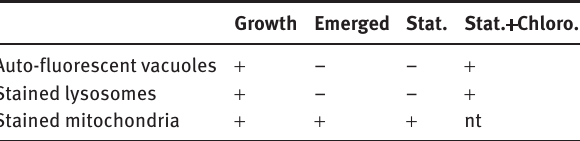
Table 1: Summary of the fluorescent properties of the auto- fluorescent vacuoles, lysosomes stained with NBD-PZ, and mitochondria stained with MitoTracker